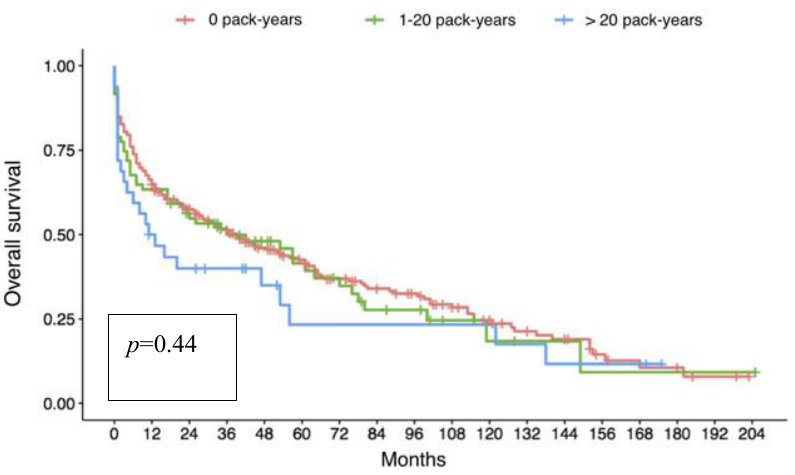
Figure 1. Kaplan-Meyer analysis of overall survival of the three groups according to donor smoking history; no difference can be observed between the three populations even though a slight trend of reduced survival is present in group III (donors with a smoking history of more than 20 pack-years).